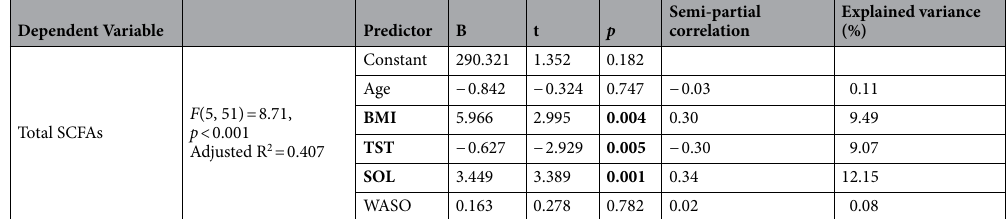
Table 3. Results of a multiple linear regression analysis predicting total SCFA concentration by age, BMI, TST, SOL, and SE. p -value in bold indicates a significant